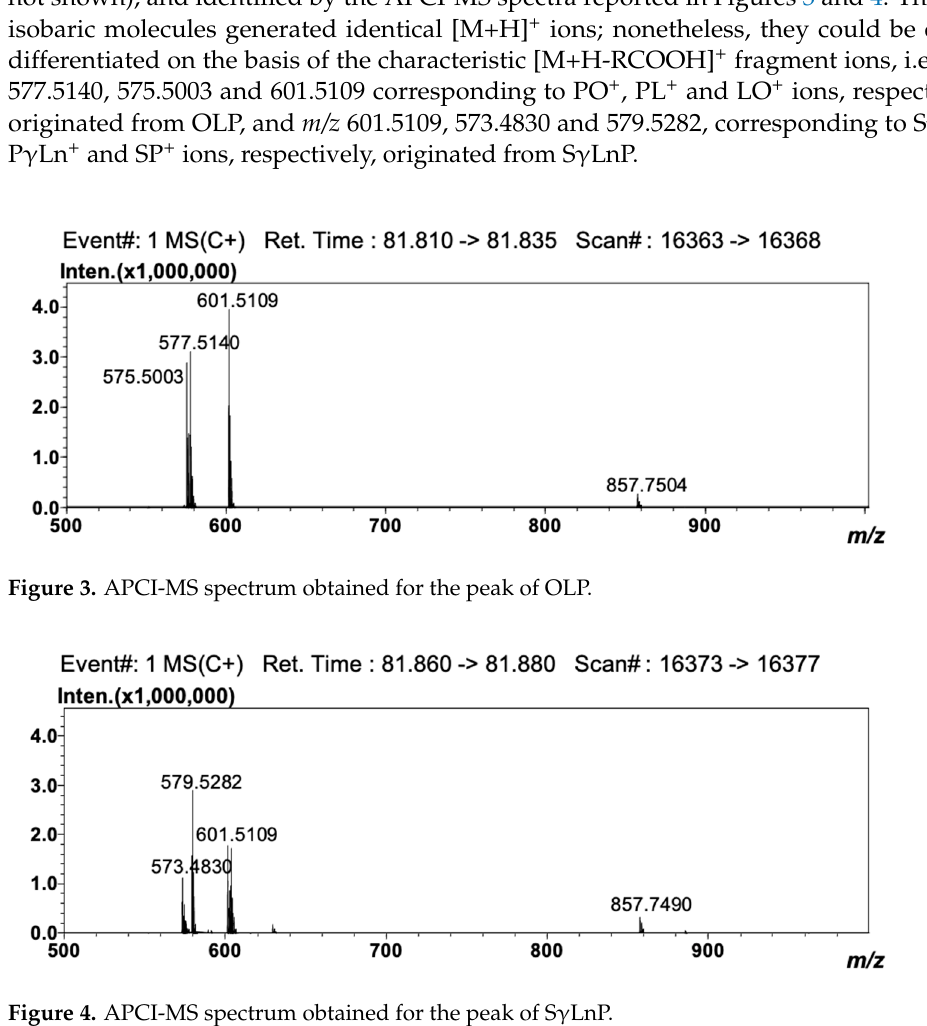
Figure 4. APCI-MS spectrum obtained for the peak of S γ LnP.